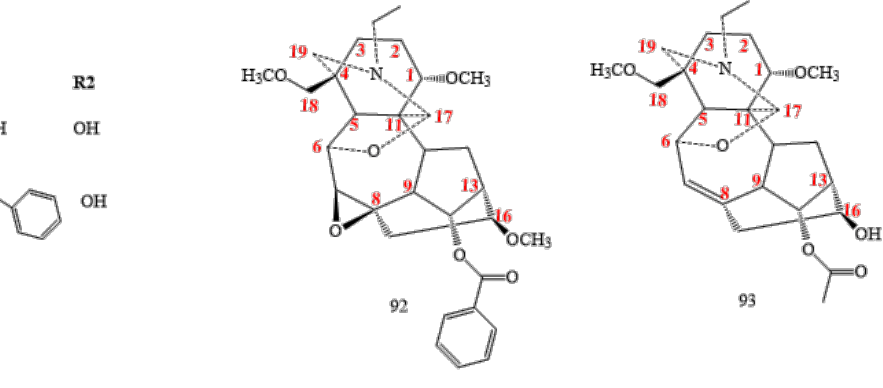
Figure 9. C 19 -franchetine DAs.